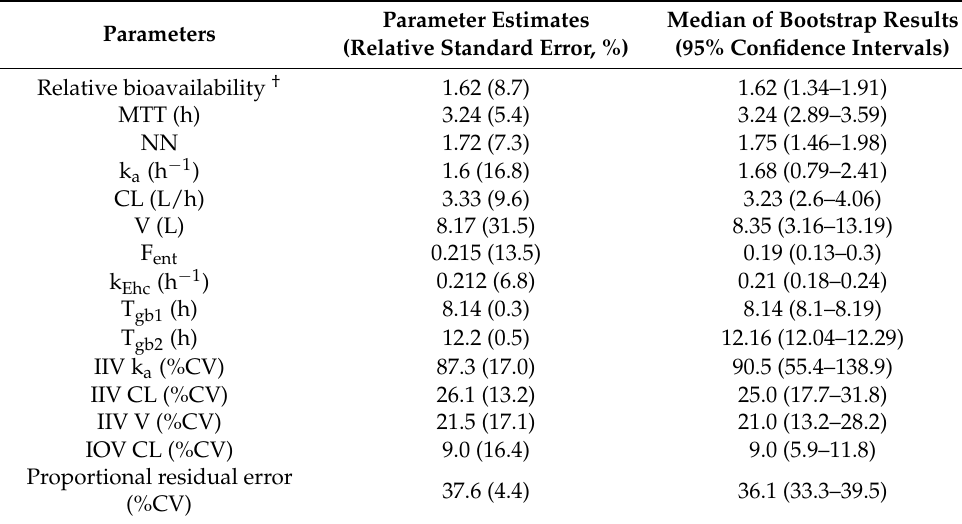
Table 2. Parameter estimates of the final model and bootstrap